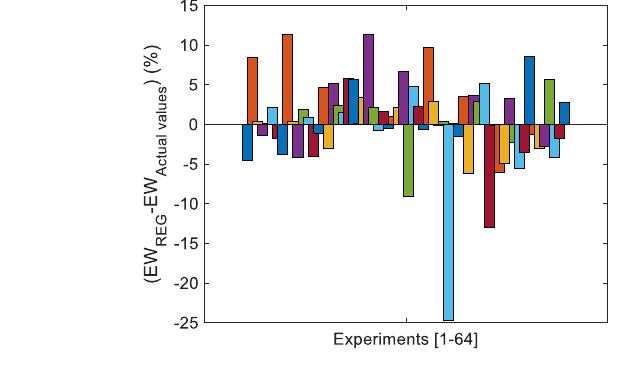
Figure 33. Validation metrics for the (ANFIS, ANN 3-8-1 , Regression) models. Type 1 function (Ra). The data for obtaining these graphs have been taken from Ref. [61]).